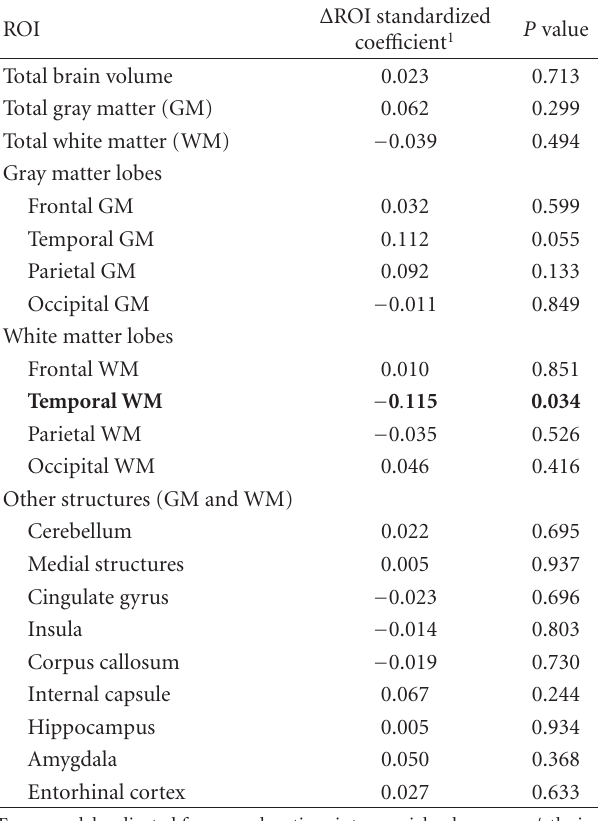
Table 3: Adjusted associations between change in ROI volumes (independent variable) and social engagement (dependent vari-